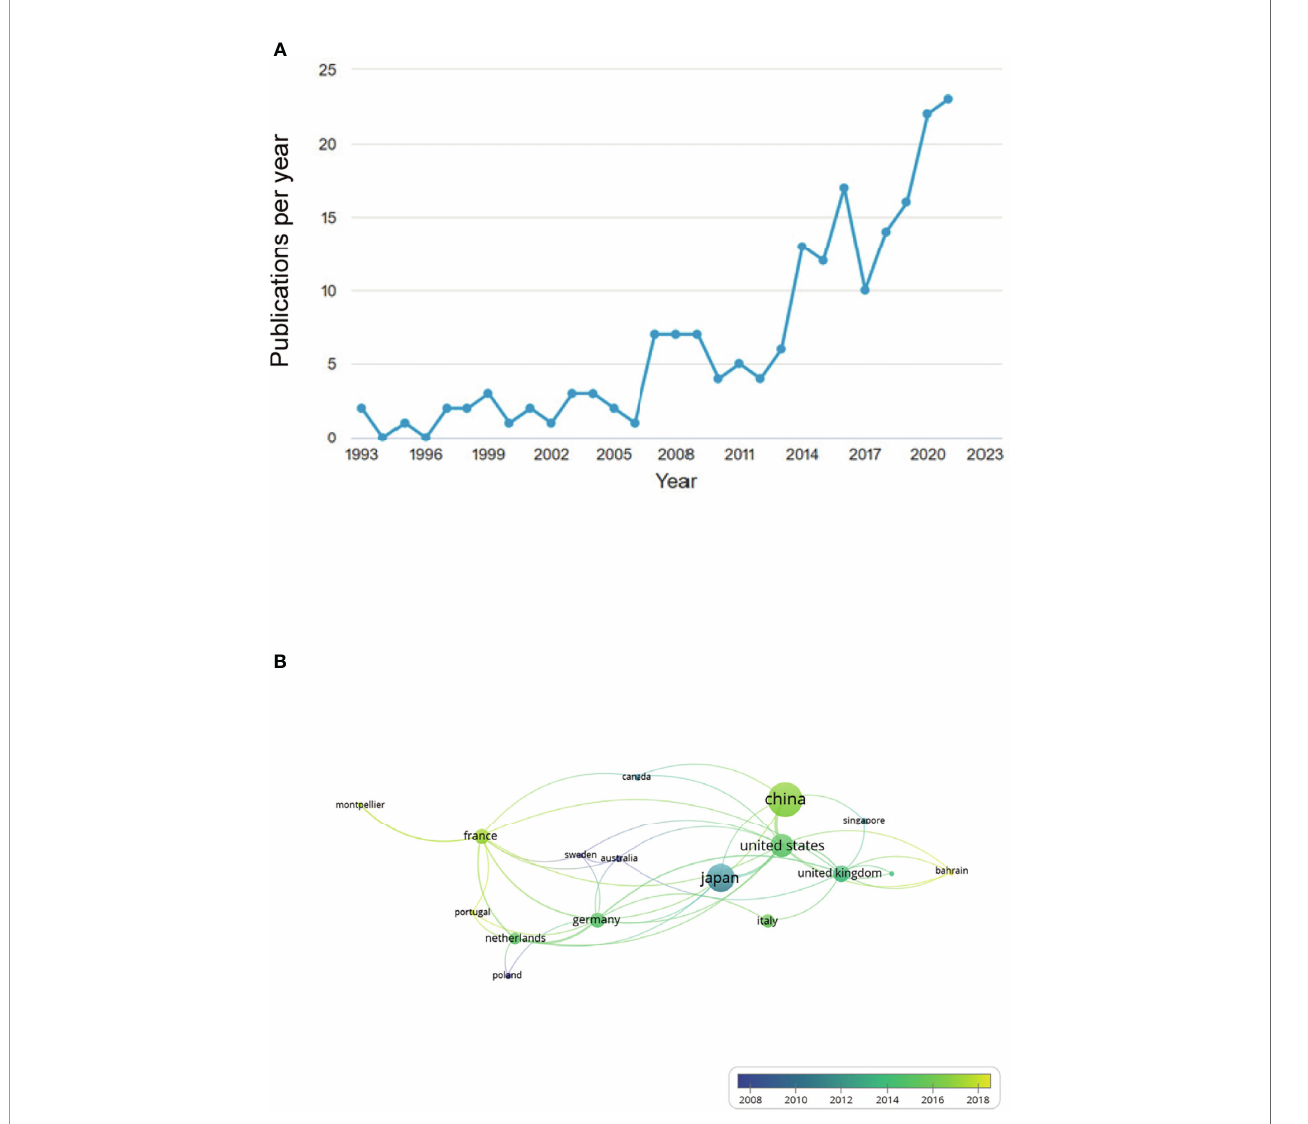
FIGURE 1 | Annual number of publications related to gd T cell and cancer increased from 2014 to 2021 and international cooperation in related research occurred between different countries. (A) Before 2006, there were few studies on gd T cell and cancer progression, annually, but number of studies increased from 2014 and peaked by 2021. (B) Numerous national connections were established in this fi eld of study, with China, Japan, and the US emerging as the most productive